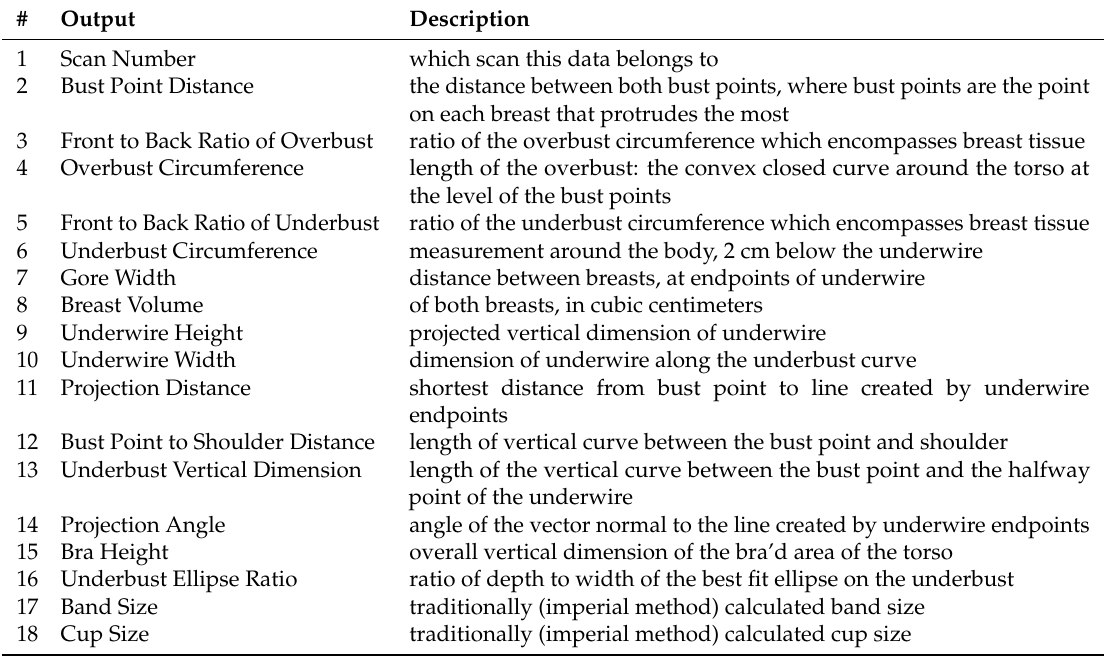
Table 1. Body scan extracted